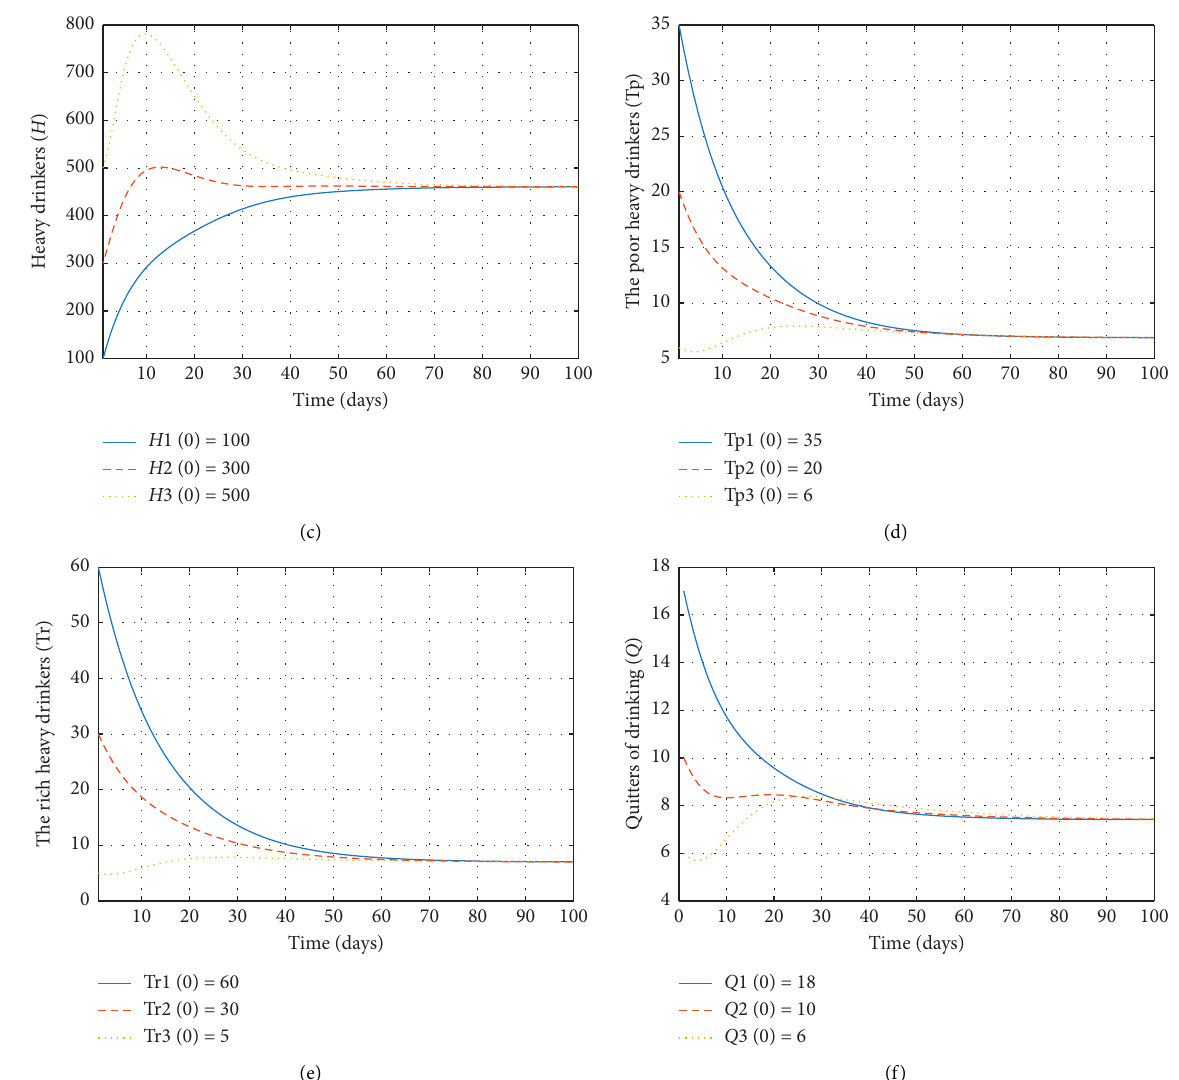
Figure 3: When R 0 < 1, the drinking-present equilibrium E